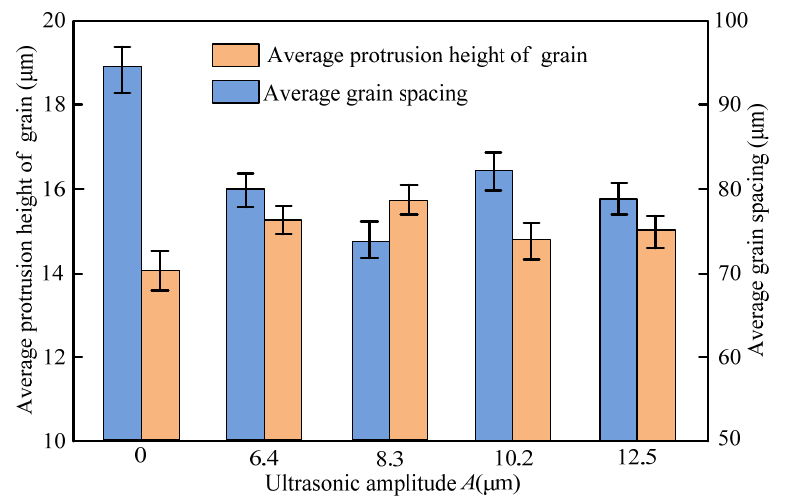
Figure 12. Average protrusion height and spacing of grains on the wheel surface under different ultrasonic amplitude.